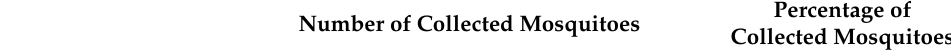
Table 1. List and proportion of mosquito species of 4381 mosquitoes collected on two crocodile farms around Darwin between March and April